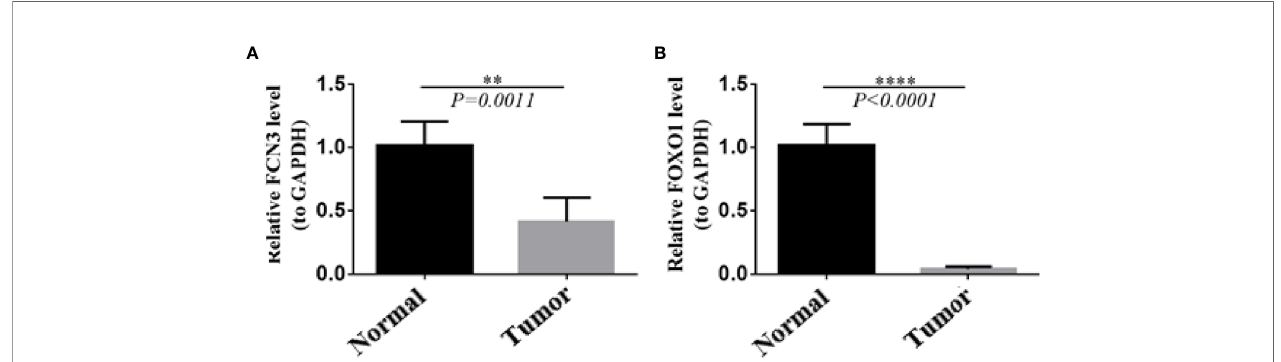
FIGURE 13 | Validation of the expression level of two hub genes using qRT-PCR. (A) FCN3, (B)